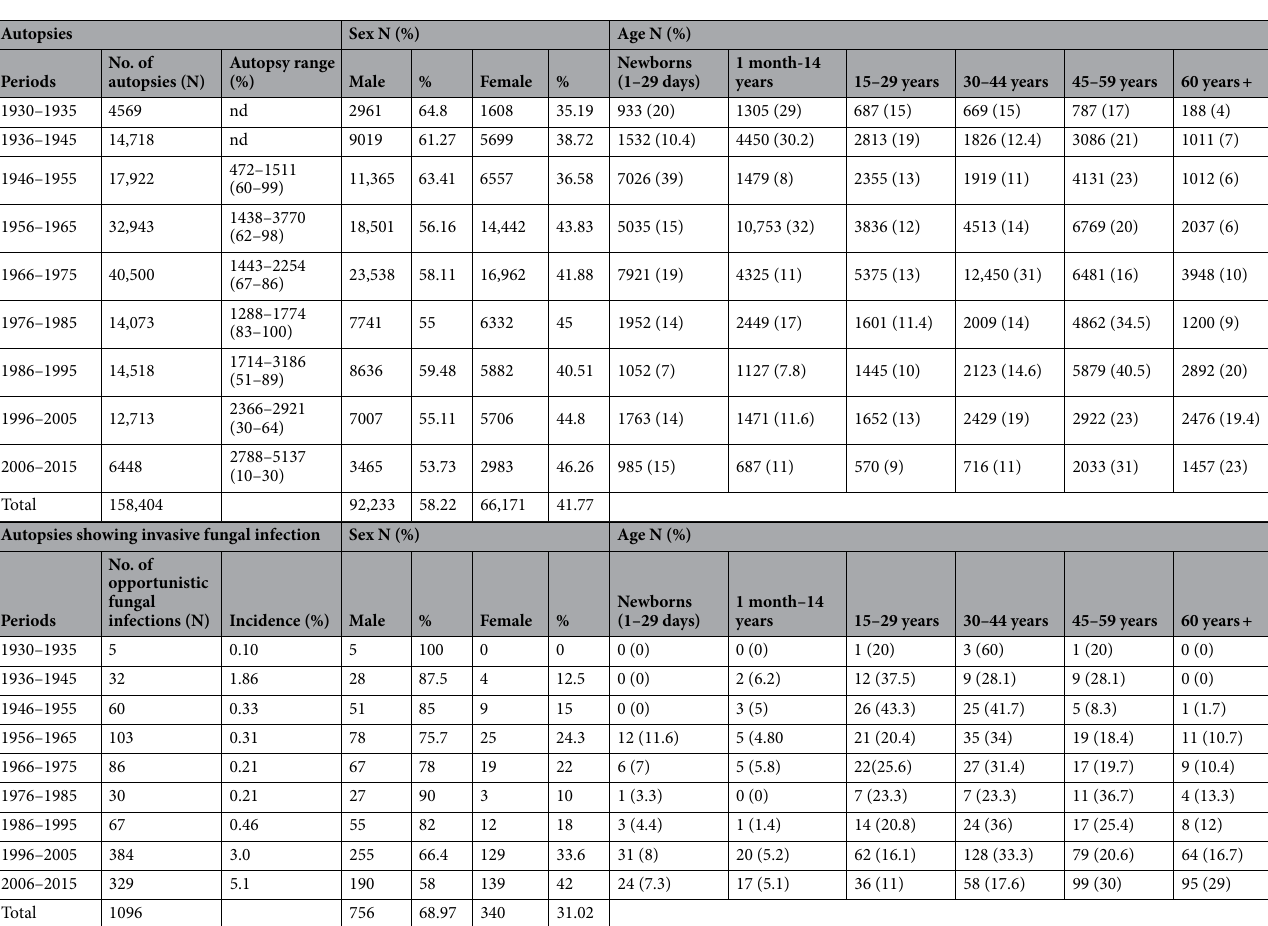
Table 1. Numbers of hospital autopsy rates, sex and age by period (decade): total and fungal infection autopsies. Nd no data, d days, m months, y years, N number, %